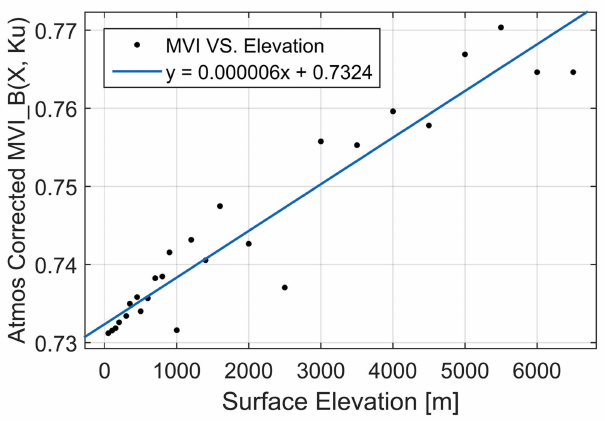
Figure 3. Influence of surface elevation on the atmospheric correction of MVI _ B ( X , Ku ) , when land